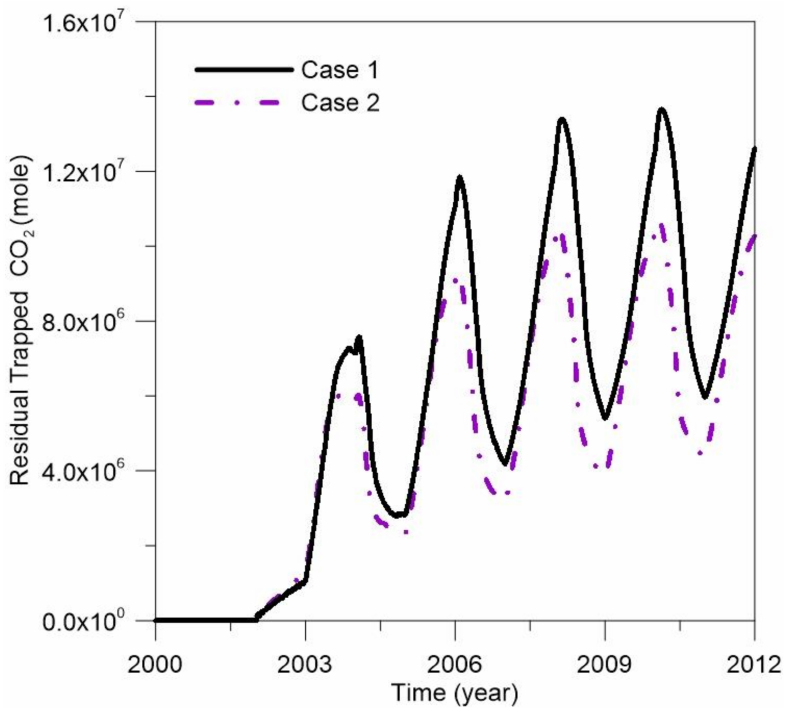
Figure 9. Residual CO 2 trapped by hysteresis during CO 2 and impure CO 2 WAG